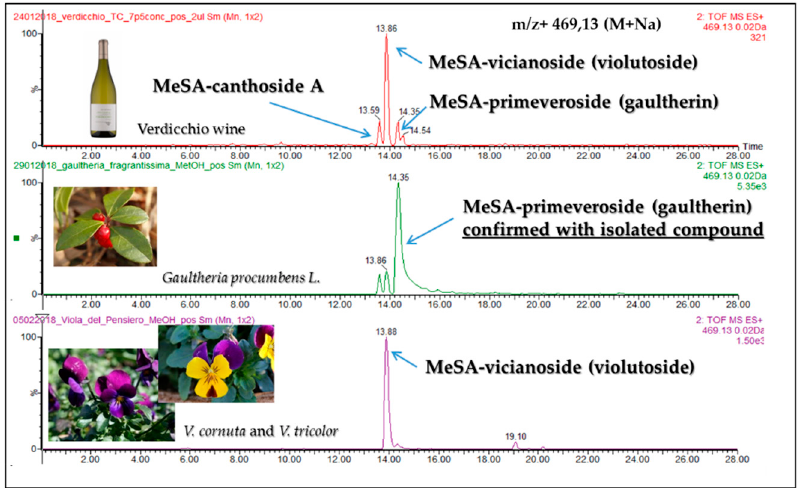
Figure1. Extractedchromatogramof m / z 469.13with the3diglycosideisomers found inVerdicchio Figure 1. Extracted chromatogram of m / z 469.13 with the 3 diglycoside isomers found in Verdicchio wine .